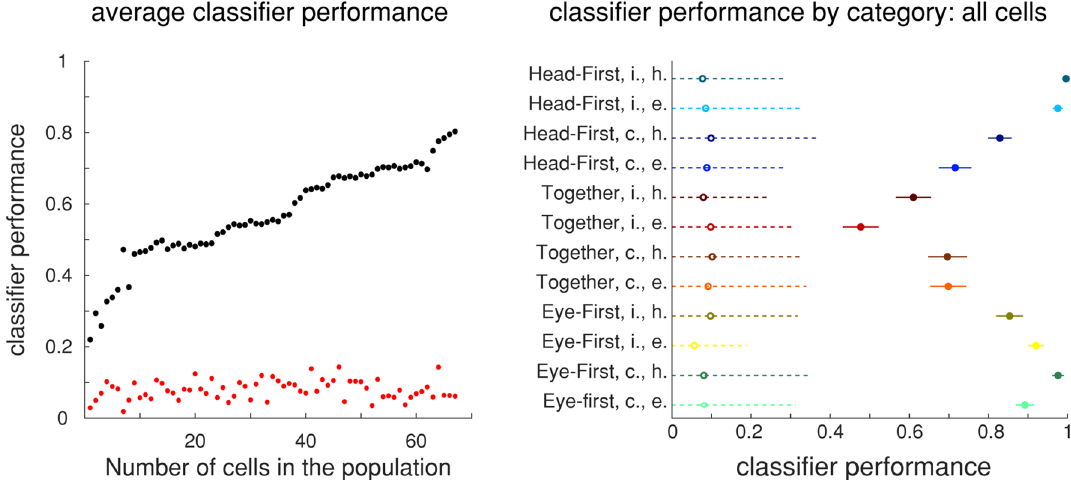
Figure 8. Naïve bayes decoder performance. Left: Black points indicate average decoder performance as a function of number of neurons used in the training population. Red points denote analogous information except when the training labels were randomized. Right: Mean decoder performance with two standard deviations span at full population separated by category. Open circles are performance from a decoder trained on shuffled